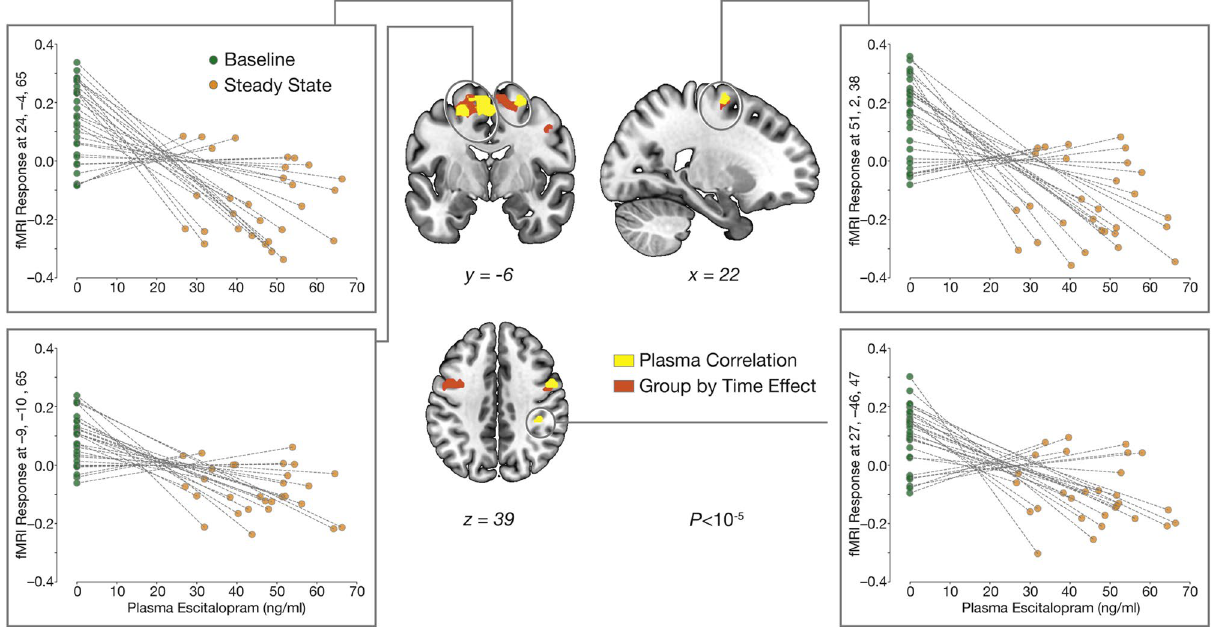
Figure 3. Correlation between decreased PPI Learning contrast and steady state escitalopram plasma kinetics. Inclusion of plasma escitalopram levels at both baseline and steady state as a covariate of interest shows a significant negative correlation between task dependent differences in functional thalamo-cortico connectivity in multiple motor regions (yellow). Results indicate a greater decrease in task-based thalamic connectivity with greater levels of escitalopram at steady state. Overlaid in red are the clusters from the significant group by time interaction (Fig. 1 - Interaction ). All results are presented at a p < 10 –5 cluster corrected threshold with a minimum cluster extent of 20 voxels. BOLD